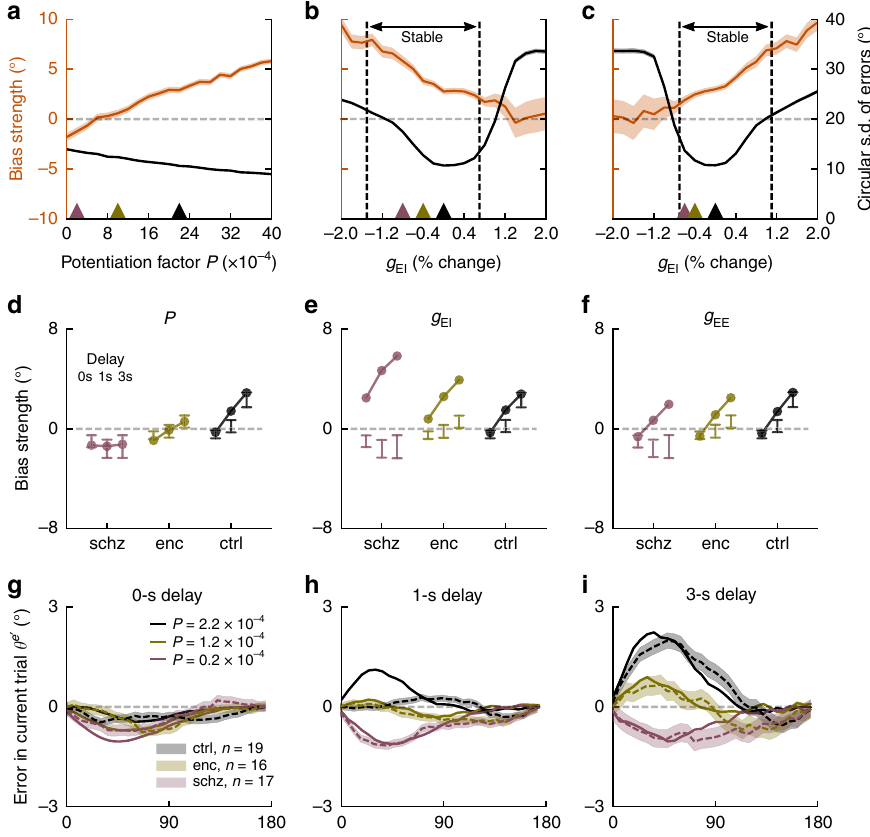
Fig. 3 Altered STP simulates reduced serial dependence in spiking neural networks. a – c Serial dependence (orange, bias coef fi cients from linear model, “ Methods ” ) and precision (black, circular s.d. of errors) as a function of model parameters in 3 s delay trials (20,000 trials per parameter value). Vertical (cid:1) (cid:1) (cid:1) (cid:1) > 57.3°, i.e., 1 radian). Shading, 95% C.I. dashed lines indicate transition to unstable network regimes for which more than 10% of trials were outliers ( θ e for regression estimates of bias coef fi cients in simulated responses. a Serial dependence decreased gradually when decreasing STP (potentiation factor P ), while the network remained stable for all simulated values of P . Precision changed slightly as a function of STP. b Cortical disinhibition via decreased g EI augmented serial bias while strongly affecting precision and stability, either due to instability of persistent activity (right, Supplementary Fig. 14b), or due to instability of spontaneous activity (left, Supplementary Fig. 14a). c Lowering recurrent cortical excitation ( g EE ) led to the opposite pattern, decreasing biases. d – f Delay dependence of biases for each group, as de fi ned by parameter values in ( a – c ), (respectively colored triangles). Points depict mean bias strength (over 20,000 trials) for each parameter value. For comparison, error bars indicate 95% CI for bias strength obtained from n = 19 healthy controls (ctrl), n = 17 patients with schizophrenia (schz), and n = 16 patients with anti-NMDAR encephalitis (enc) (reordered from Fig. 1g – i). d Lowering STP strength reproduced the experimental data. In e , f reduction of NMDAR conductances ( g EI or g EE ) did not reproduce group and delay dependencies of experimental biases. g – i Solid lines, simulated serial dependence by delay length for different values of P , indicated by colored triangles in ( a ) (20,000 trials per potentiation level P ). Dashed lines with error bars, serial dependence in encephalitis, schizophrenia, and healthy controls. Bias calculated as averaged ‘ folded ’ error θ e 0 for binned absolute previous-current distances θ d . Shading, ±s.e.m. Compare to Supplementary Fig. 15 for a network with STP (and STP disruptions in patients) in both E – E and E – I